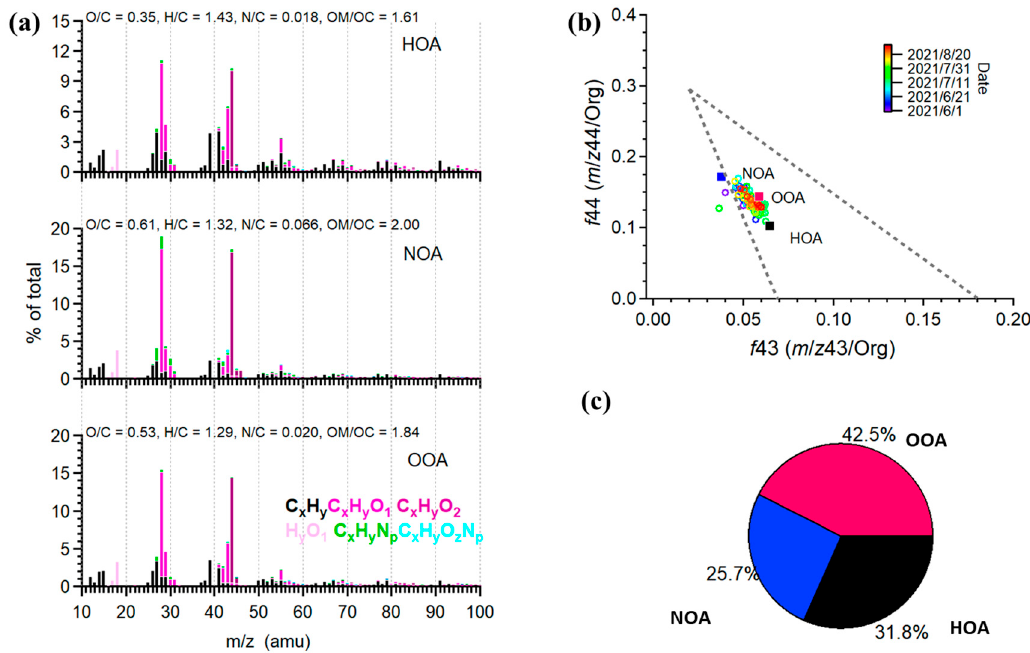
Figure 4. ( a ) High-resolution mass spectra and time series of WSOA components of 3-factor solution from PMF (left panel), ( b ) triangle plots (f44 vs. f43) of WSOA, and ( c ) contributions of resolved factors to WSOA in summer.